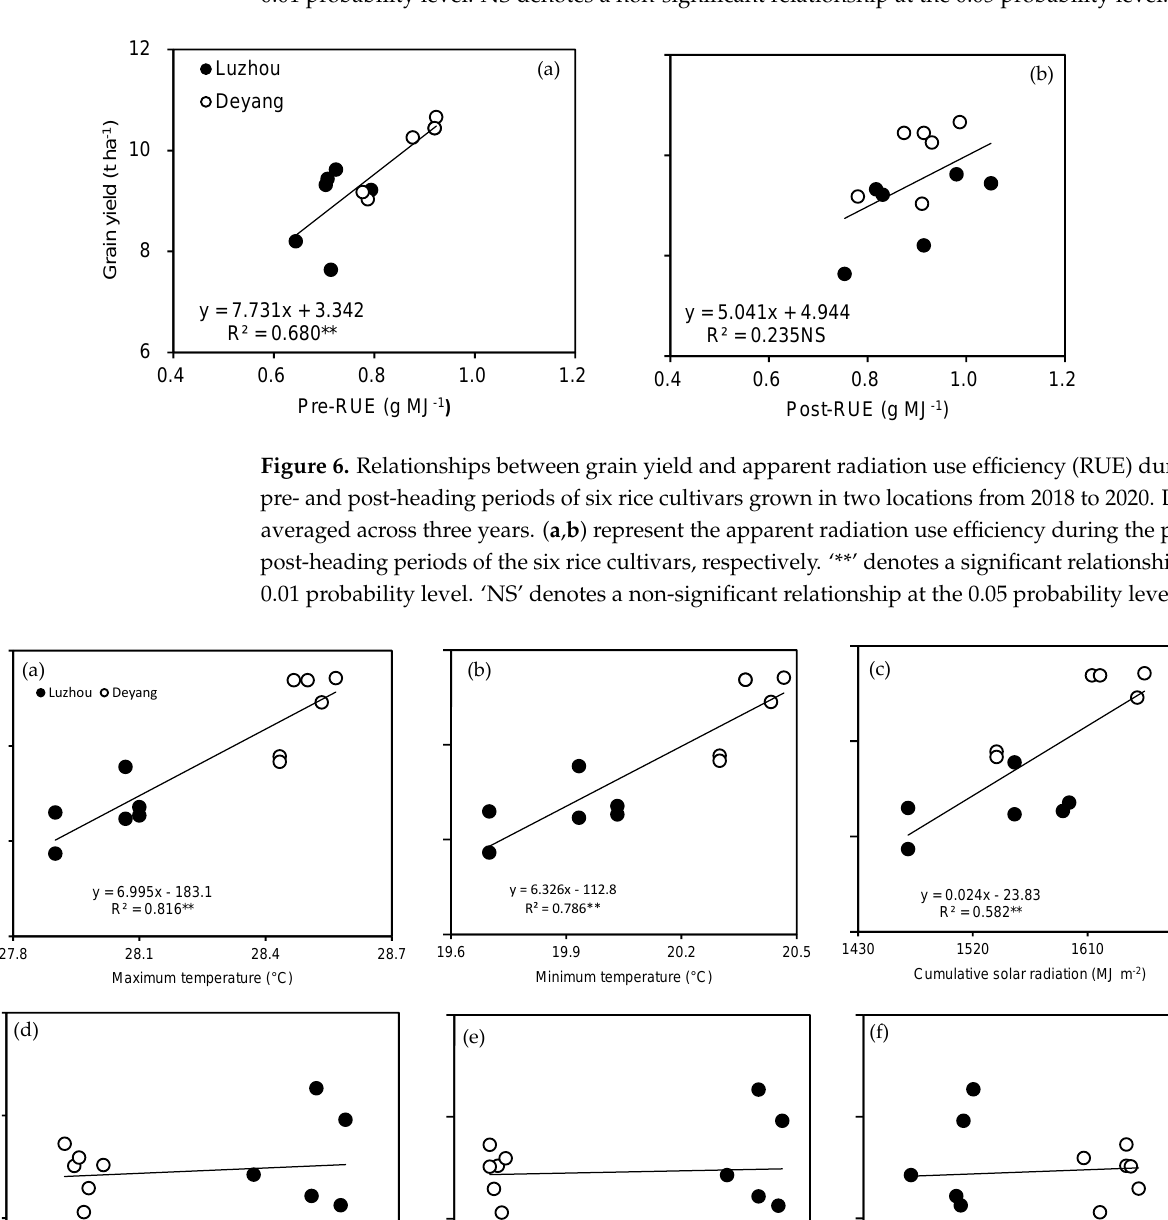
Figure 5. Relationships between grain yield and crop growth rate (CGR, g m −2 d −1 ) during the pre- and post-heading periods for six rice cultivars grown in two locations from 2018 to 2020. Data are averaged across three years. ( a , b ) represent the crop growth rate (CGR, g m −2 d −1 ) during the pre- and post-heading periods of six rice cultivars, respectively. ‘**’ denotes a significant relationship at the 0.01 probability level. NS denotes a non-significant relationship at the 0.05 probability level.